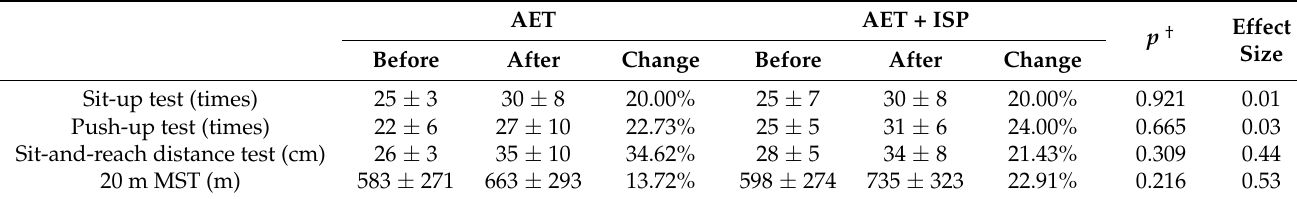
Table 5. Physical fitness of the AET and AET + ISP groups before and after 8 weeks of intervention. AET